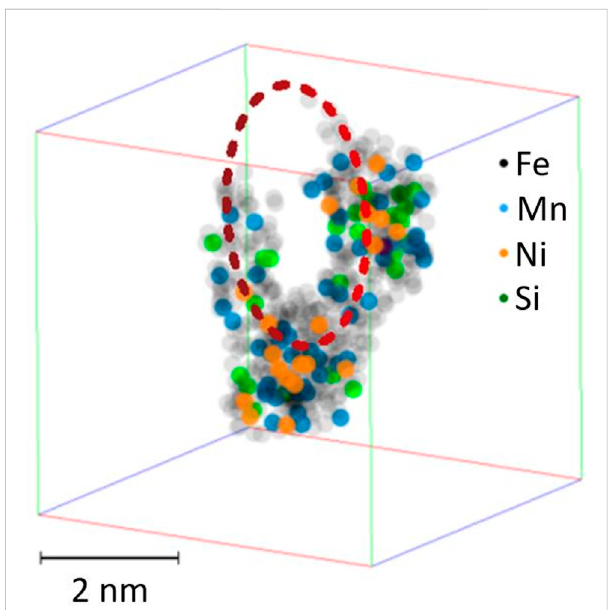
FIGURE 8 Loopdecoratedwithsoluteatomsas revealedbyanAPTstudy of a neutron-irradiated RPV steel, reproduced with permission from (Wagner, 2017).